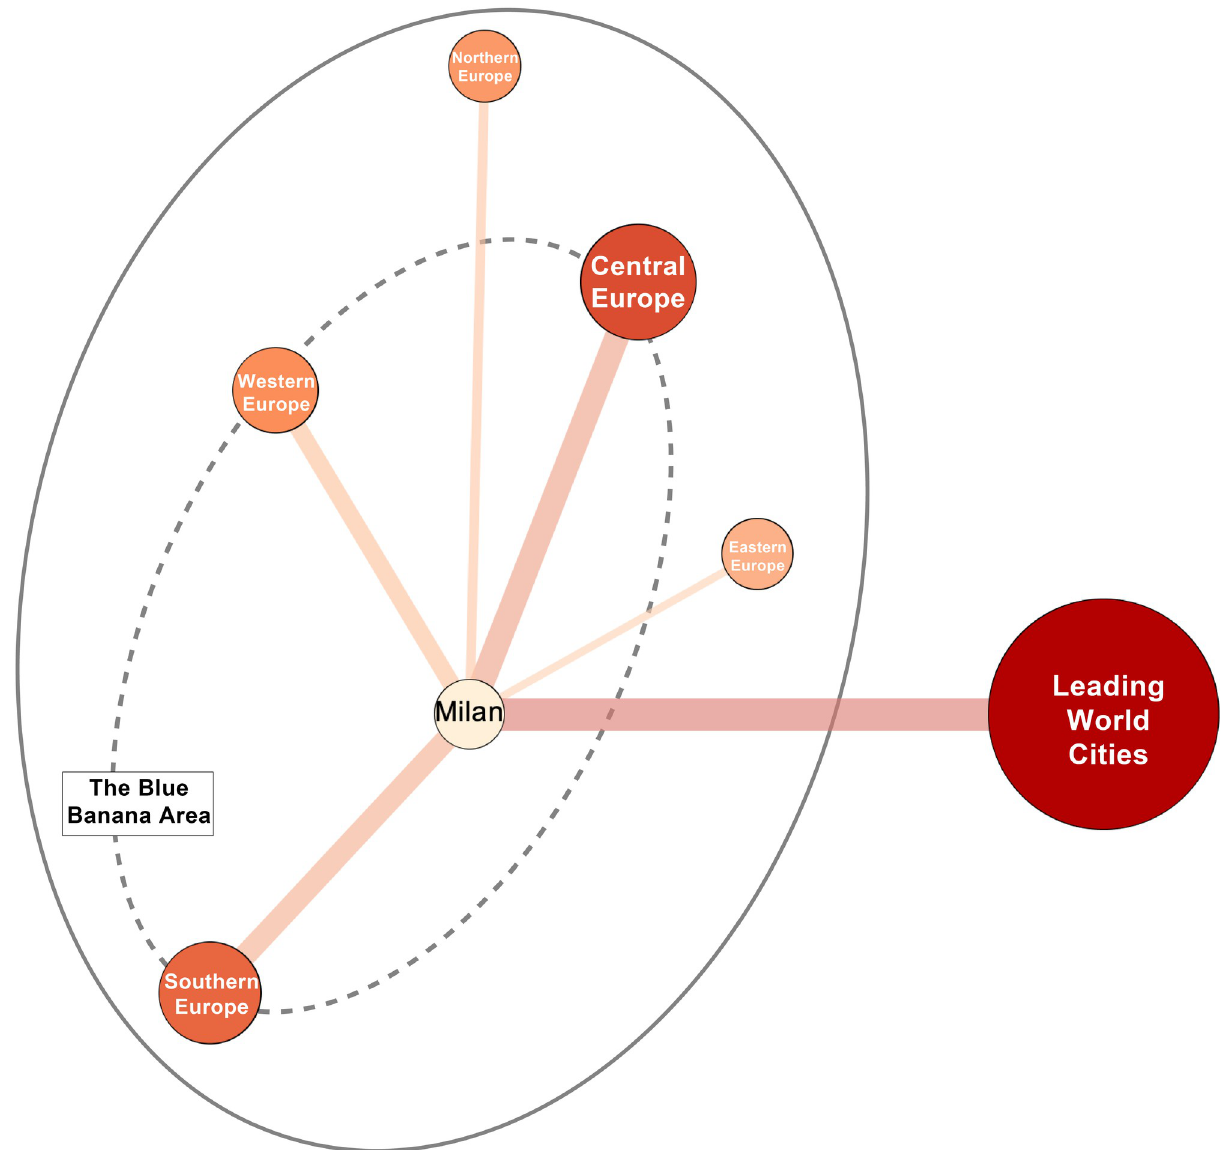
Fig 3. Rough interlocking strength between Milan and major cities in different macro-regions in Europe and leading world cities.